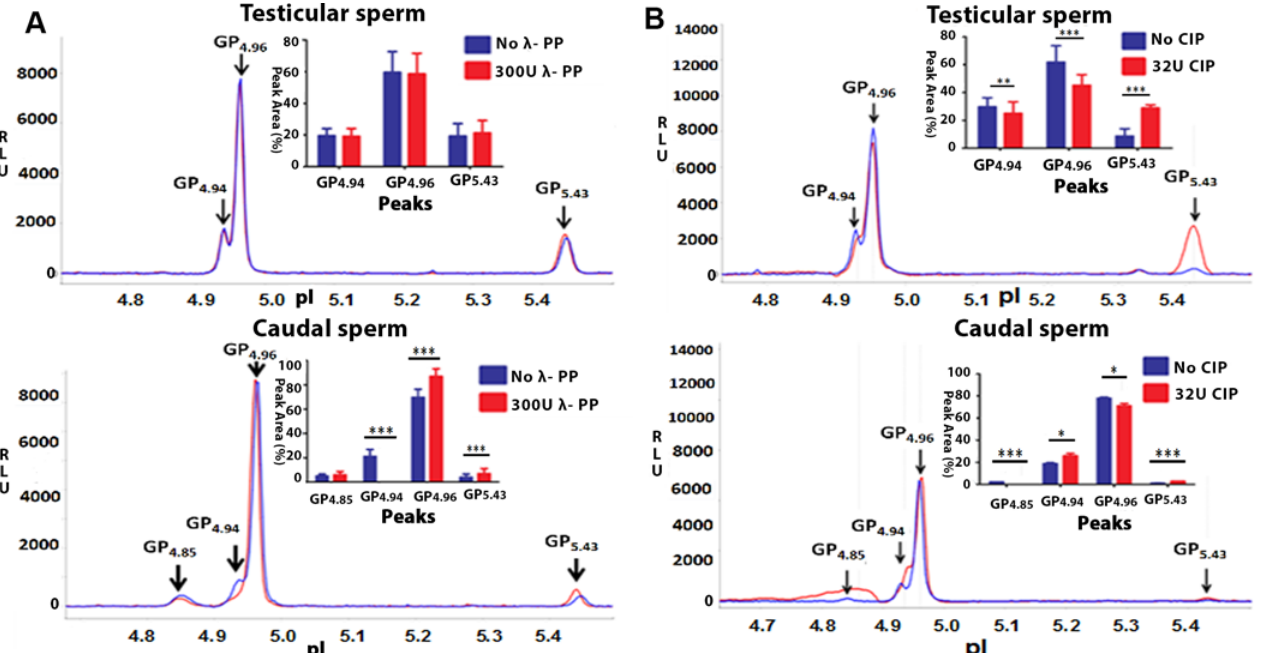
Fig 5. Phosphorylated forms of GRP78 in rat testicular- and caudal sperm. 100 μ g of testicular- or caudal- sperm protein was incubated for 2h without or with 300U of λ -PP at 30°C ( A ), or without or with 32U of CIP at 37°C ( B ) followed by NIA using 20ng of protein lysate thus treated to detect the GRP78 peaks. Figure shows representative isoelectropherograms for testicular- (Upper panel) and caudal- sperm (Lower panel). Figures in inset represent bar diagrams of the cumulative data. Values are mean ± Standard Deviation (SD). Statistical significance was determined using Paired Students ’ ‘ t ’ test and significance level set at P (cid:3)